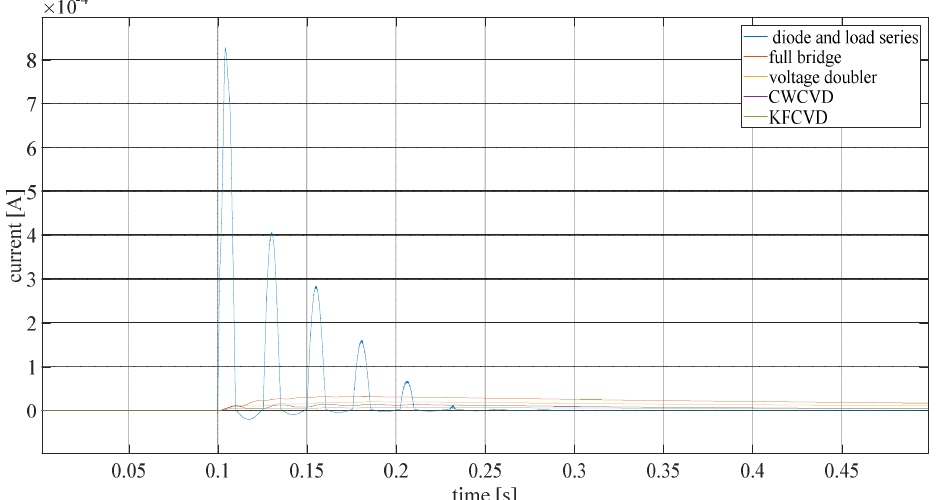
Figure 17. Current on the load in different cases for a single raindrop hitting the piezoelectric harvester. Blue color indicates the performance of the diode load series circuit. Orange is the performance of the full bridge circuit; yellow is that of the Greinacher doubler, pink is that of the CWCVD and finally green is that of the KFCVD.